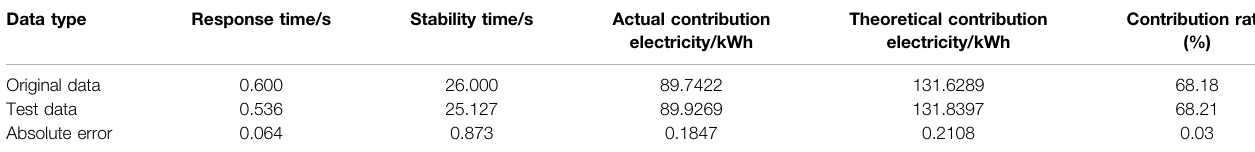
TABLE 5 | PFM assessment parameter table of downward disturbance.